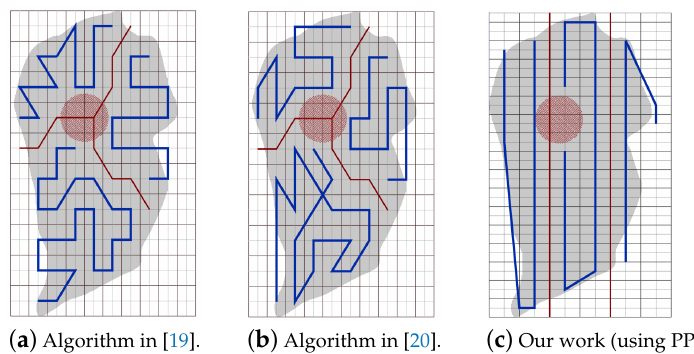
( c ) Our work (using PPS-L).